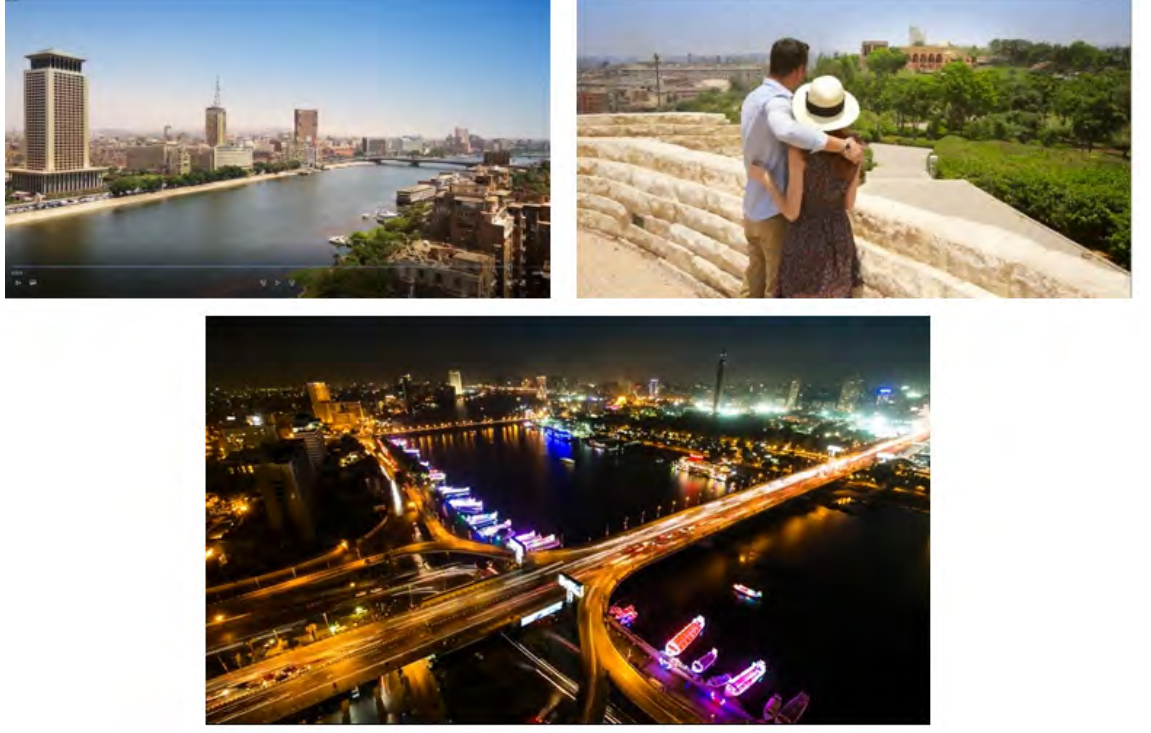
Figure 14. shows public spaces, ( Nile valley – Alazhar park ) (New Egypt Old Friends,